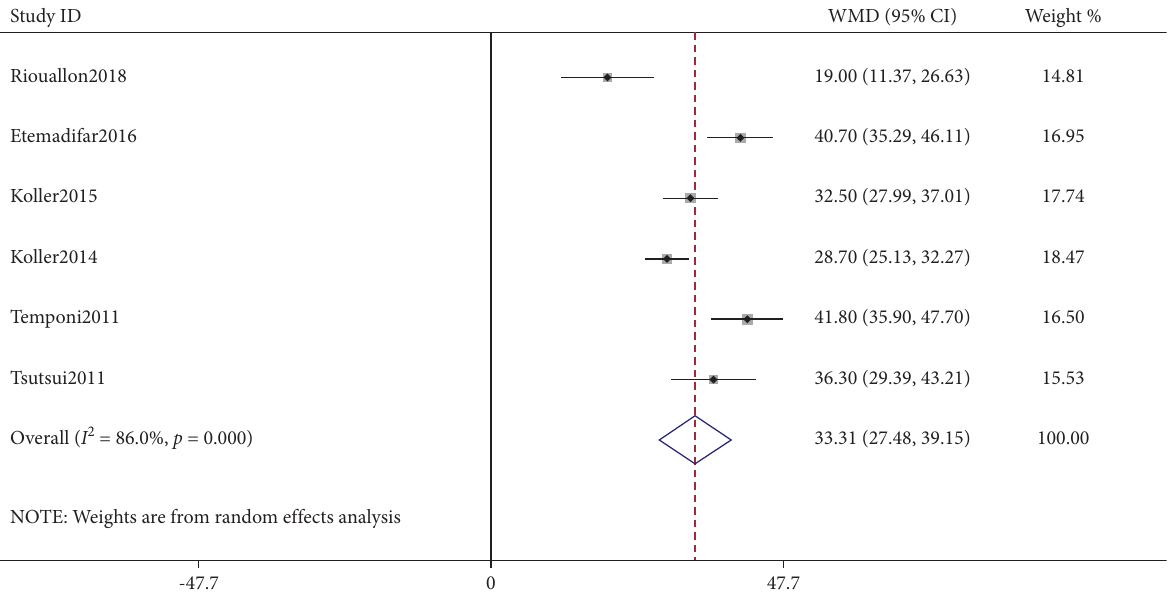
Figure 2: Forest plot of kyphosis correction by the combined anterior-posterior